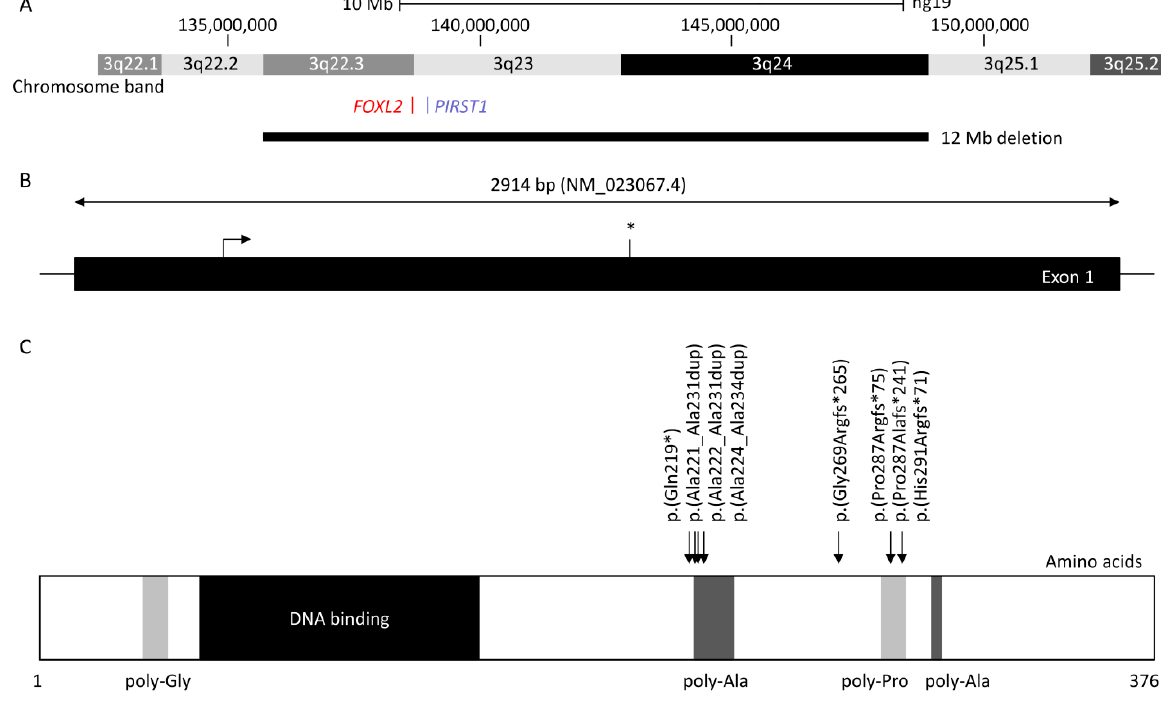
Figure 1. Diagram showing forkhead box L2 ( FOXL2 ), up- and downstream genomic position, protein structure, and hotspot located in the poly-alanine domain. ( A ) Chromosomal deletions were reported in at least 84 blepharophimosis, ptosis, and epicanthus inversus syndrome (BPES) patients, with the largest encompassing 3q22.3 to 3q24 (12 Mb) and the smallest encompassing FOXL2 or PIRST1 genes (UCSC: hg19:chr3:133,064,629-153,716,375). ( B ) FOXL2 is composed of one 2.9 kb exon (NM_02367.4). The stop codon is indicated with an asterisk (*). ( C ) FOXL2 is a 376 amino acid protein, composed of poly-glycine (amino acid position 35–43) depicted in light grey, a DNA binding protein or forkhead (amino acid 54–148) in dark, two poly-alanine (poly-Ala) region (amino acid 221–234 and 301–304) in grey, and a poly-proline region (amino acid 284–292) in light grey (Uniprot: P58012). The most common variants (more than five patients were reported) are represented herein, which affect the highly conserved poly-alanine domain (amino acid 221–234) with c.672_701dup p.(Ala224_Ala234dup) ( n = 80), c.663_692dup p.(Ala221_Ala231dup) ( n = 12), and c.664_693dup p.(Ala222_Ala231) ( n = 5), or the poly-proline domain (amino acid 284–292) with c.843_859dup p.(Pro287Argfs*241) ( n = 46), c.855_871del p.(Pro287Alafs*241) ( n = 5), and c.855_871dup p.(His291Argfs*71) ( n = 15). The nonsense variant c.655C>T p.(Gln219*) and the frameshift variant c.804dup p.(Gly269Argfs*265) were reported in 6 and 10 patients, re- spectively.